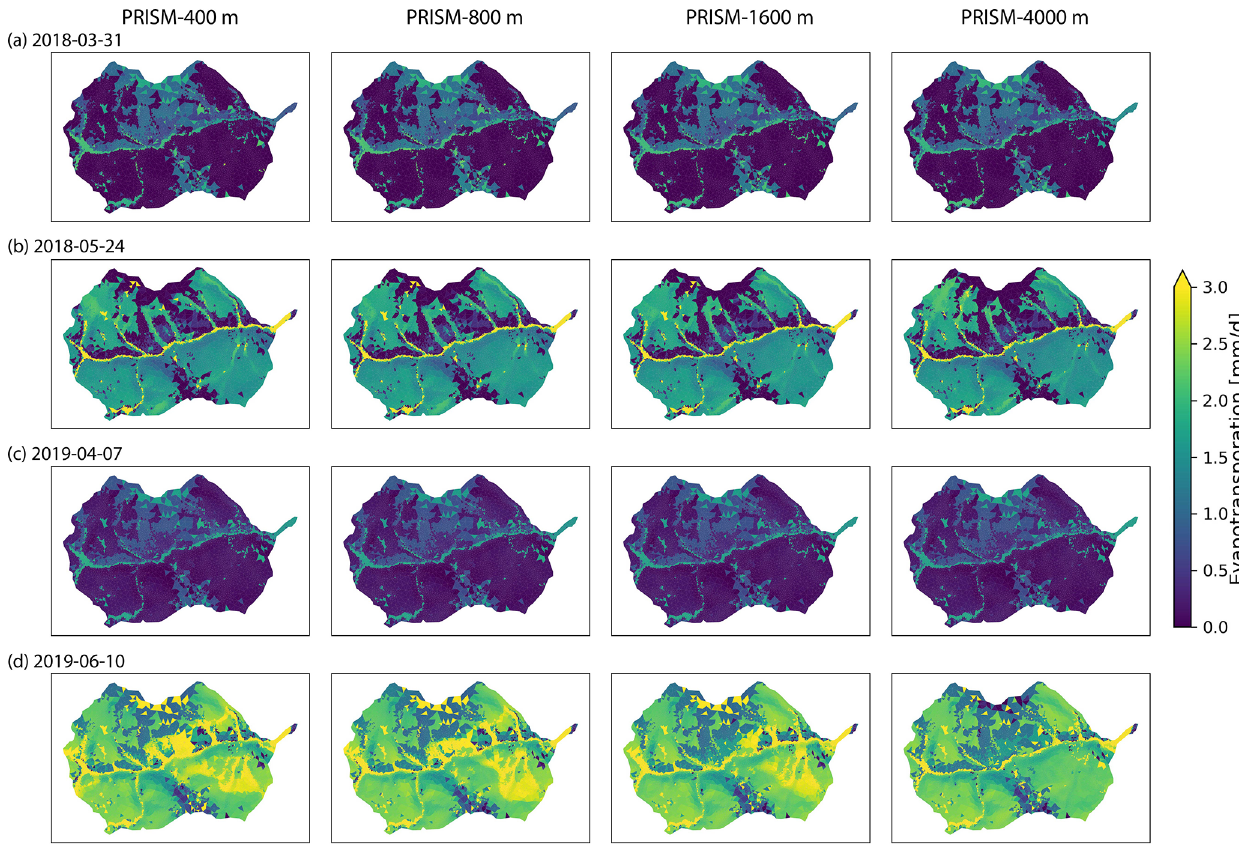
Figure A12. Spatial distribution of ET under different spatial resolutions of PRISM at four different